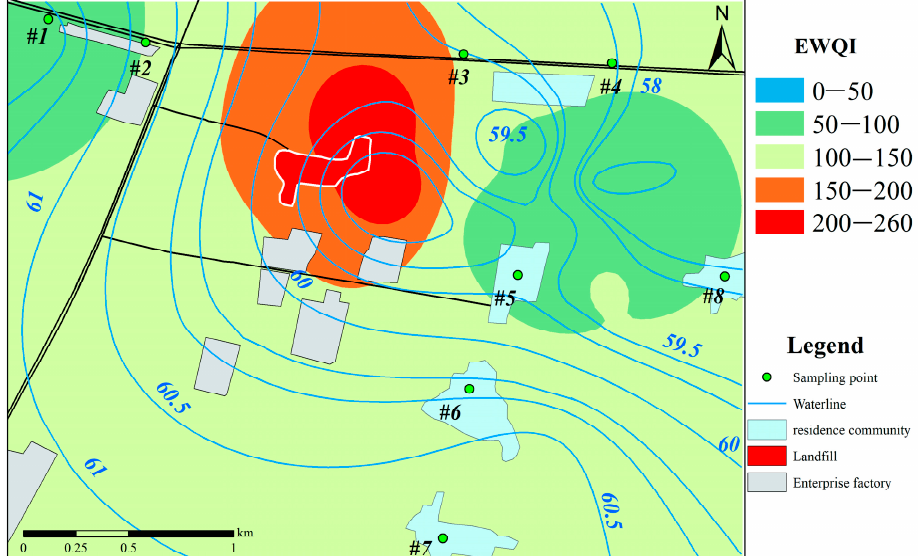
Figure 4. Spatial distribution of EWQI value levels in the study area.